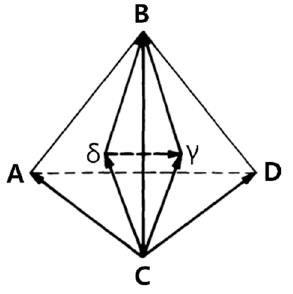
Figure 10. Thompson’s tetrahedra in the fcc structure.